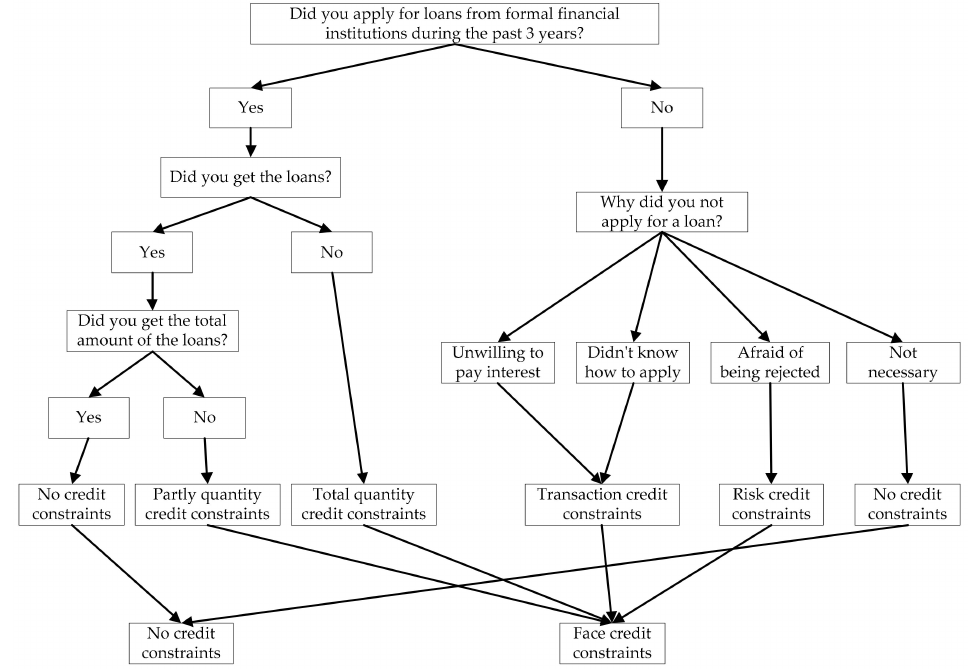
Figure 2. Assessing if an individual faces credit constraints from formal financial